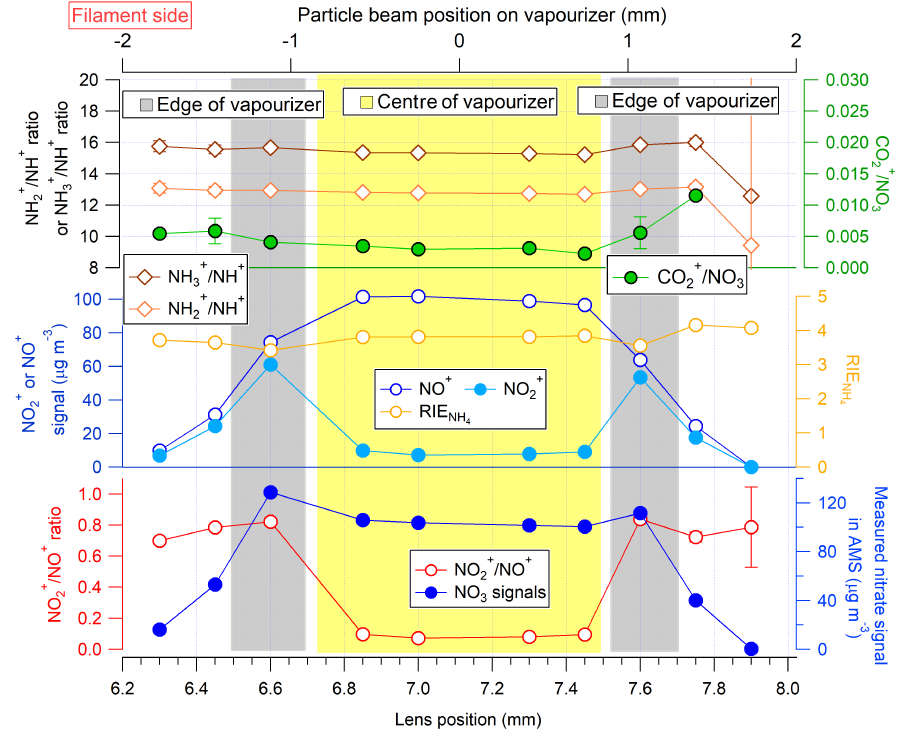
/ NO + , total detected nitrate, NO + / NH + , and NO + signals, RIE NH , NH + 2 2 2 4 / NO 3 . The shaded areas are a rough indication for where the particle beam hits the 2